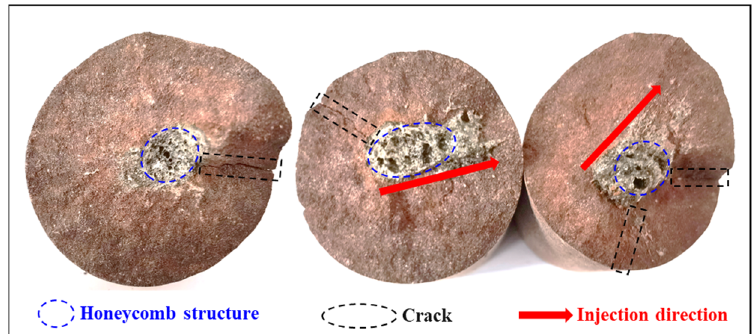
Figure 9. Honeycomb structure and jet traces on the fracture surface of the natural specimen.